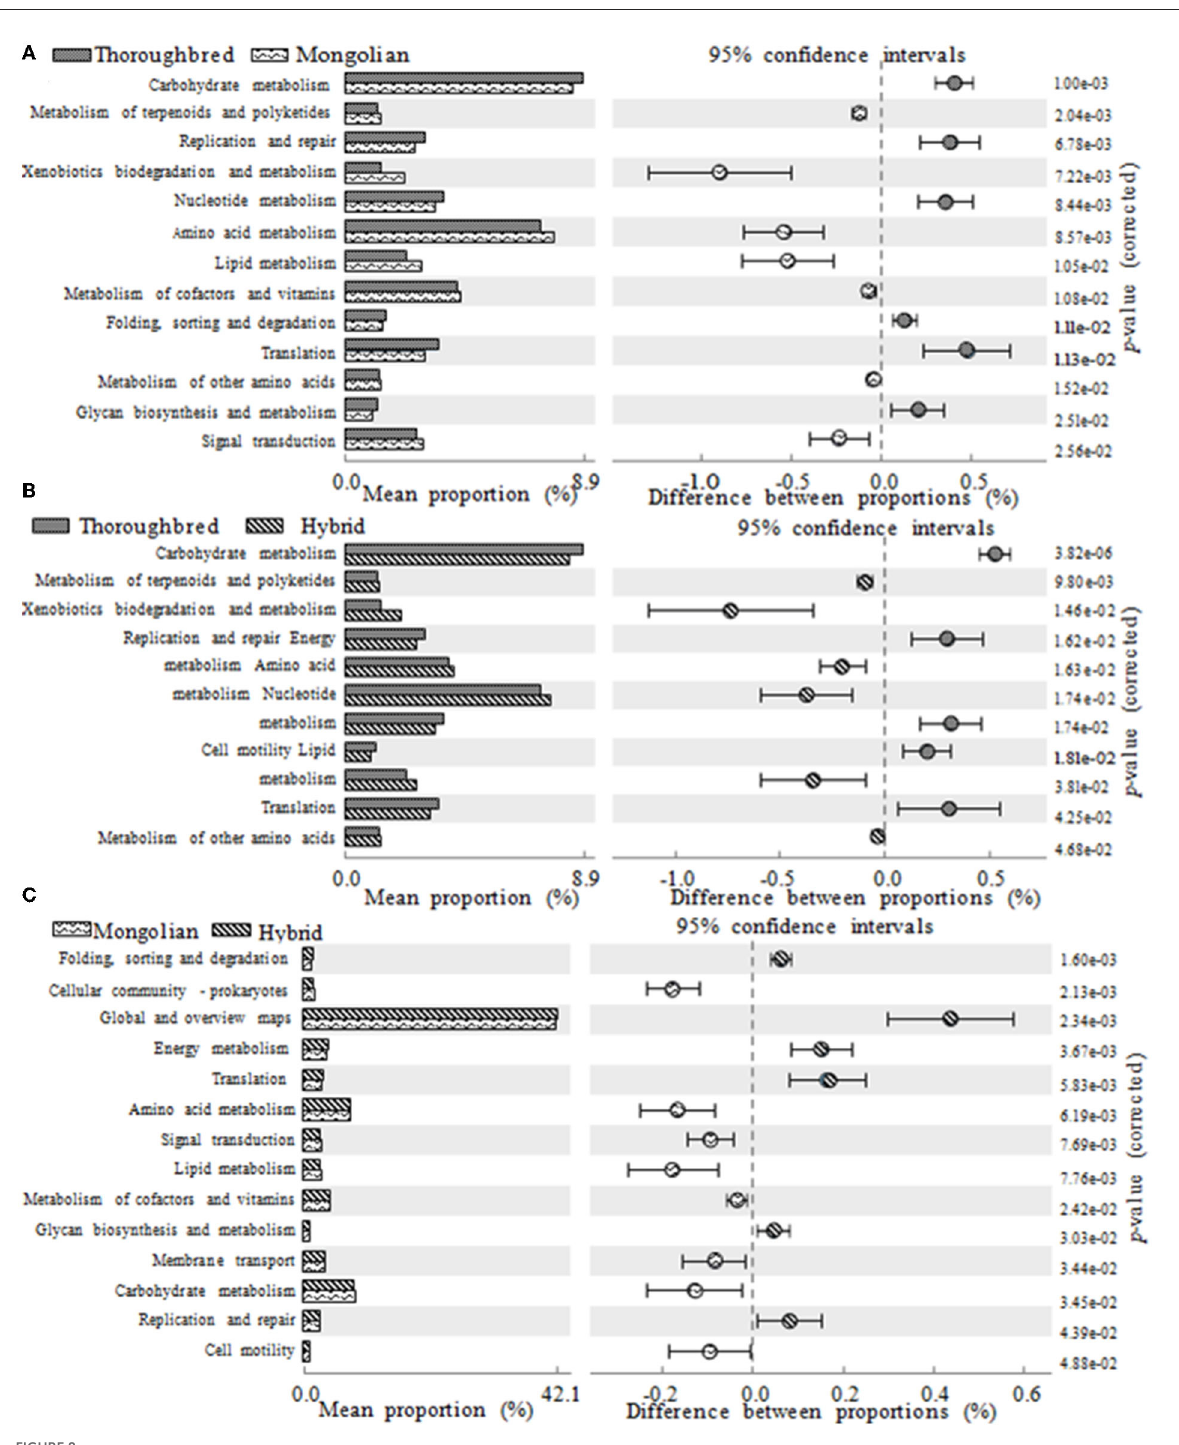
FIGURE8 Differences in KEGG (Kyoto Encyclopedia of Genes and Genomes) metabolic pathways between groups (one-way ANOVA with Tukey’s post-test , P < 0.05). (A) The functional gene differences between Thoroughbred and Mongolian horses. (B) The functional gene differences between Thoroughbred and Hybrid horses. (C) The functional gene differences between Mongolian and Hybrid